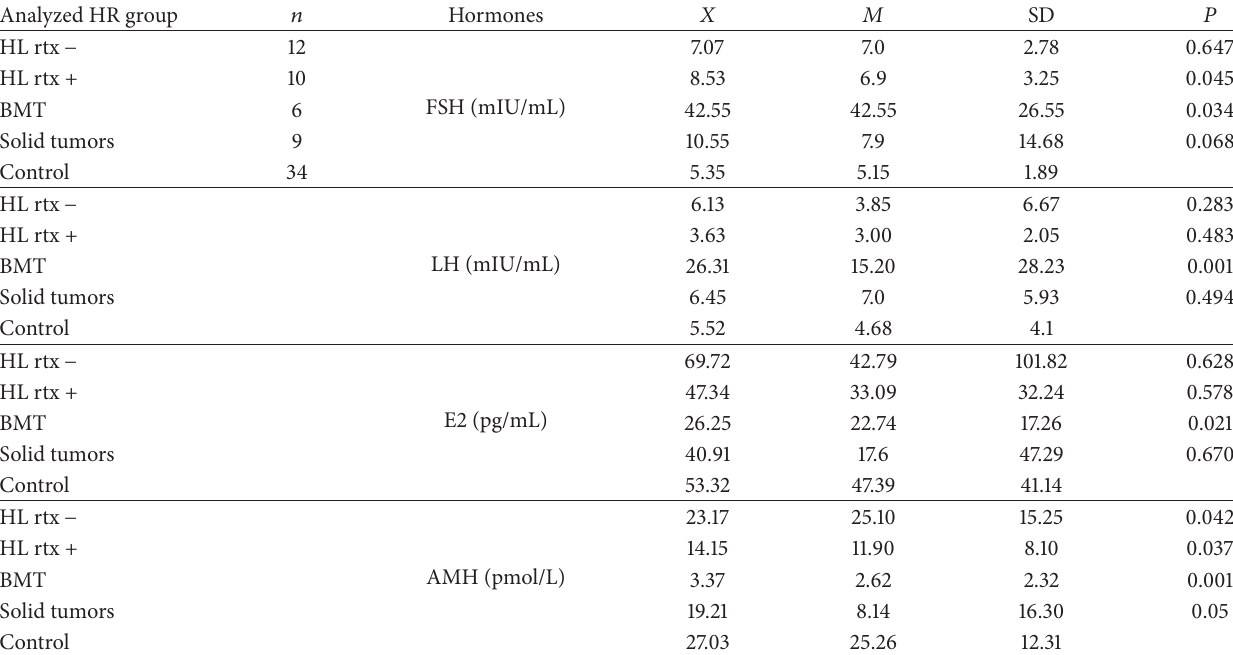
Table 3: Hormone levels in female cancer survivors classified to the high risk